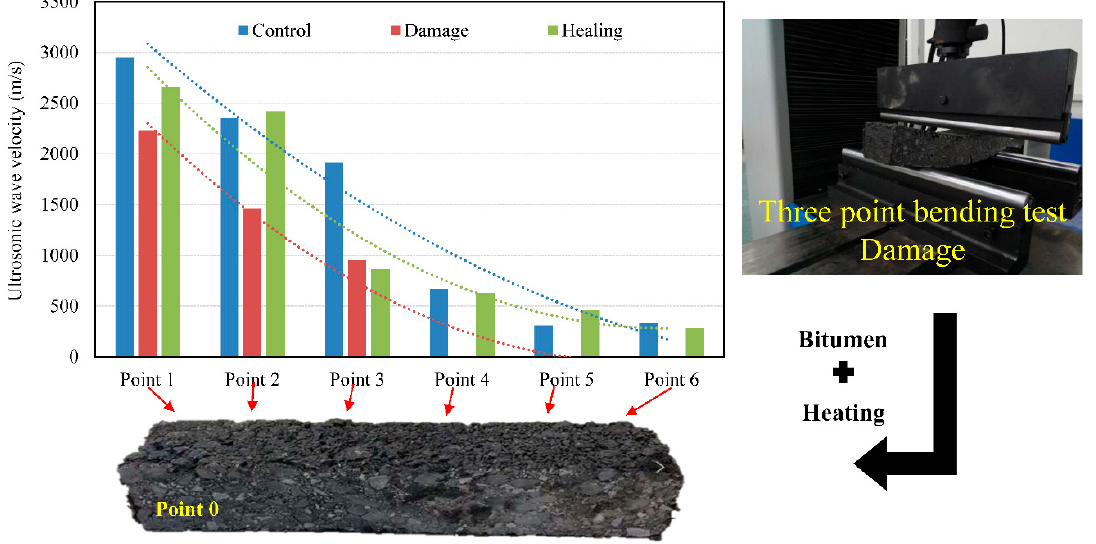
Figure 7. The velocity of ultrasonic wave in the width travel direction of the asphalt beam.